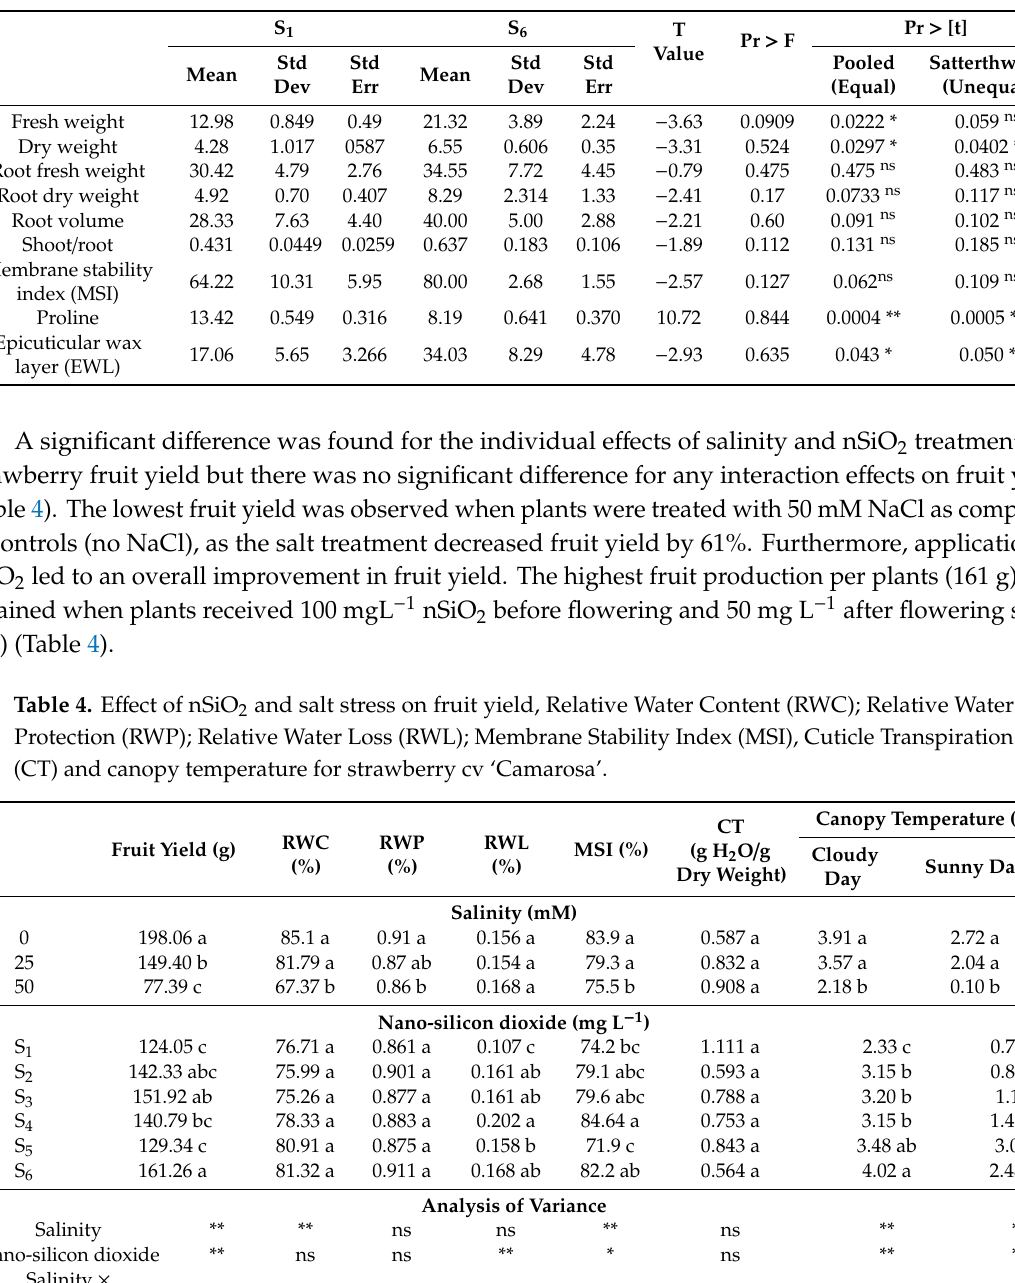
Table 3. Student’s t -test of nano-silicon dioxide e ff ects on morphological and physiological parameters of strawberry plants exposed to 50 mM NaCl salinity stress; ns (no significant di ff erence); Pr > [t] ( p -value for the e ff ect of the variable on the response and t statistic) * (significant di ff erence).